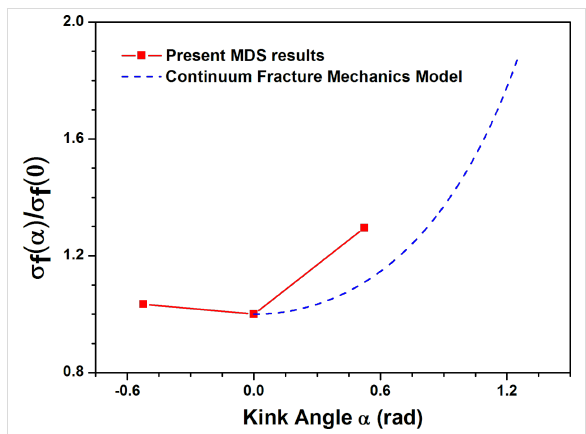
Figure 6: Comparison of fracture strength of MoS 2 sheet with the crack of 1 nm length between MDS results and continuum fracture mechanics model versus the different kink angle α , i.e., different crack tips.